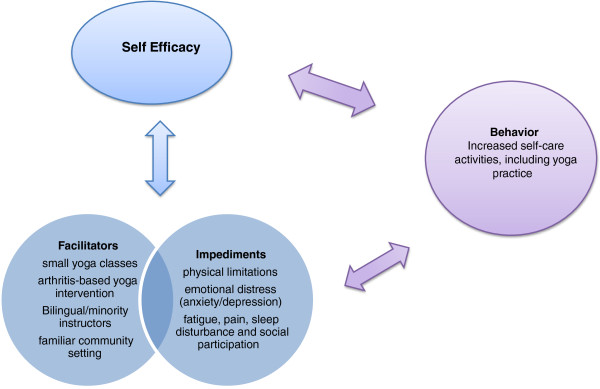
Self care model.